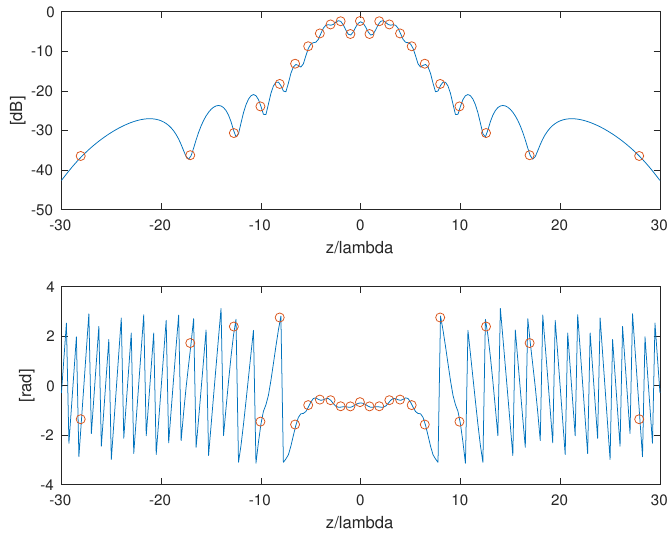
Figure 7. Near field amplitude ( top ) and phase ( bottom ) along the observation line; the sampling points using the minimum redundant spatial sampling strategy are plotted as